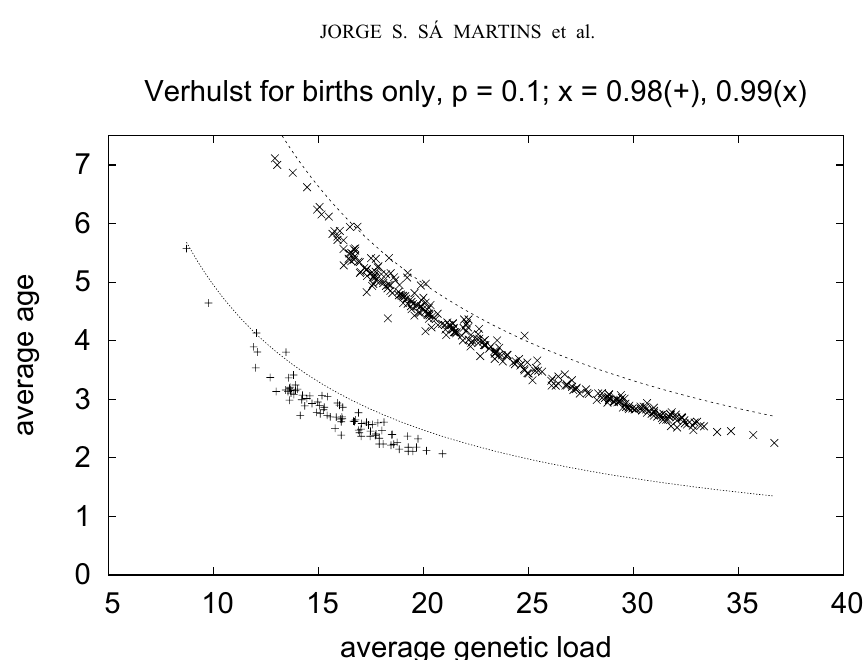
Fig. 2 – Model A1. Average age of survivors versus the number of unadapted loci, when the Verhulst deathprobabilityappliestothebirthsonly; theindividualsarerepresentedbypairsof64-bitstringsand results are shown for various values of m after some simulation time. The curves show 1 /( | lnx | N )